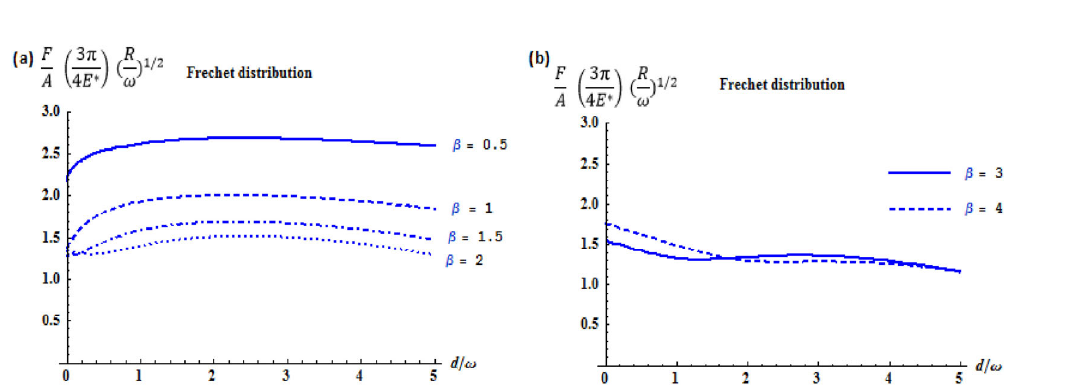
Fig. 3 The pressure of contact for the Fréchet distribution and Hertzian contact. (a) The pressure of contact does not have a monotonous trend by increasing load for β < 2 . (b) For β ≥ 2 , the pressure of contact has a rise in pressure due to a reduction in the number of short summits for larger